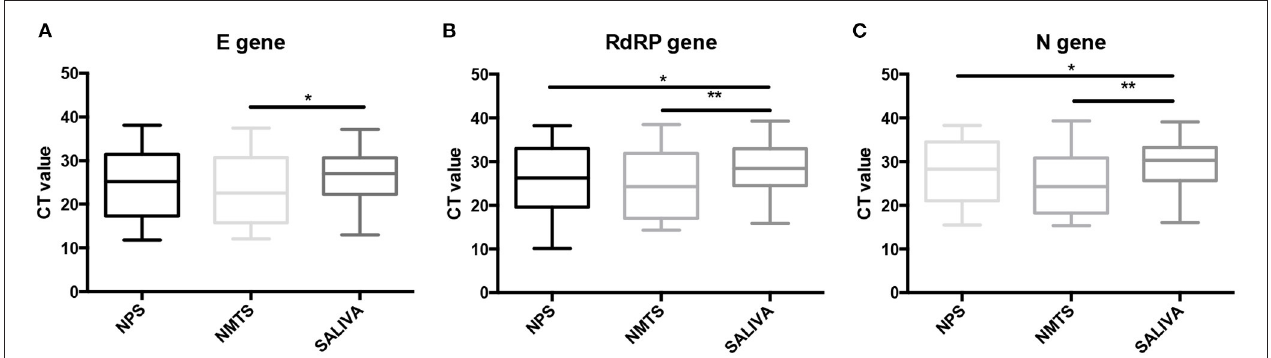
FIGURE 1 | Comparison of the RT-qPCR performance between the distinct sampling methods. Boxplots of SARS-CoV-2 Cycle threshold (Ct) values (mean and interquartile range) obtained for (A) E target gene, (B) RdRP target gene, and (C) N target gene in nasopharyngeal swab (NPS), nasal mid-turbinate (NTMS) swab, and saliva (SALIVA) samples. Statistical differences were tested using the paired t -test. * p ≤ 0.05. ** p ≤ 0.01.